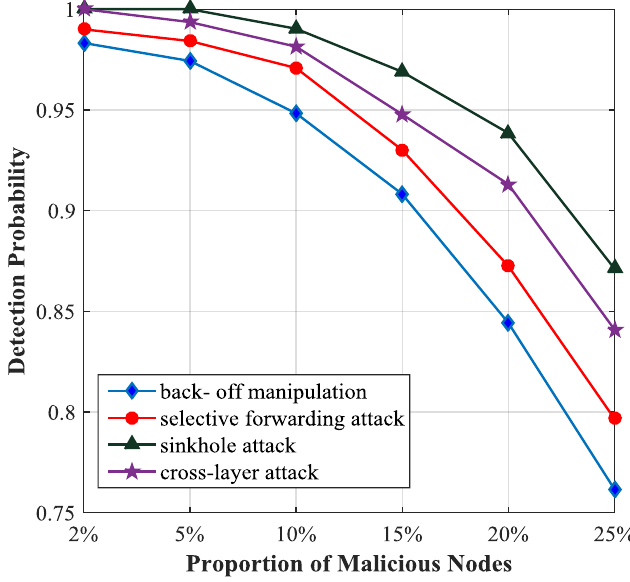
Figure 7. Detection probability with different proportion of malicious nodes .